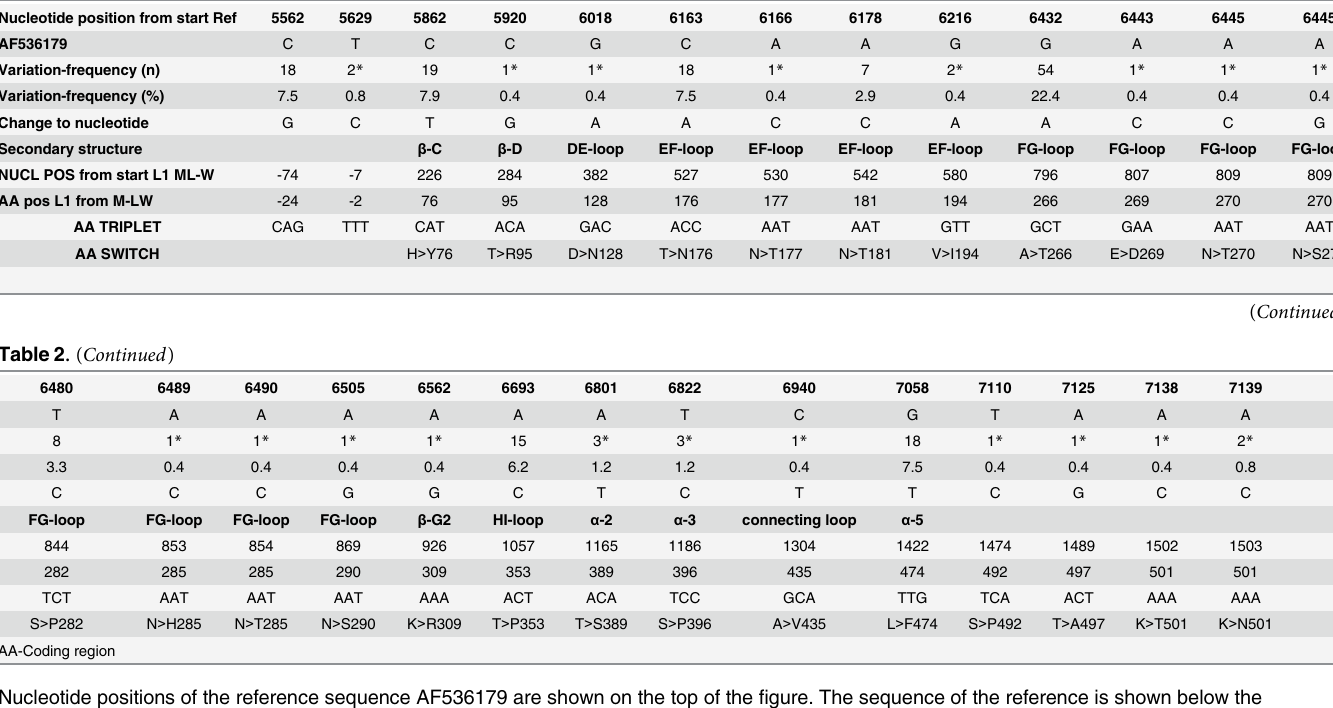
Table 2. Non-synonymous nucleotide sequence variations of HPV-16